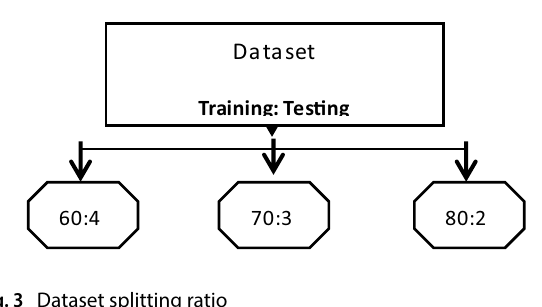
Fig. 3 Dataset splitting